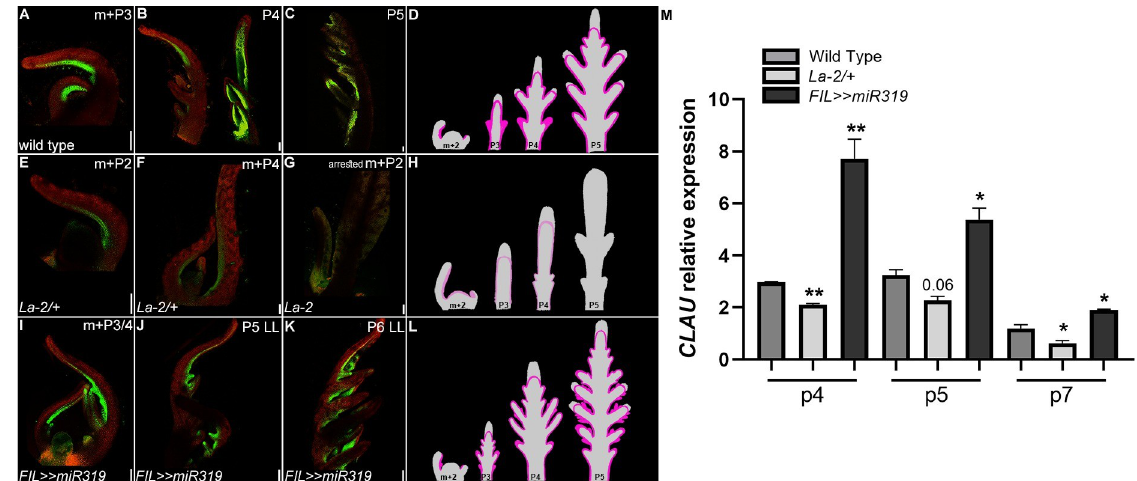
Fig 2. LA determines the developmental window in which CLAU is expressed. (A-L) Expression of the CLAUSA promoter CLAU :: nYFP in altered LA genotypes. (A-C) Expression of CLAU :: nYFP in different developmental stages of WT; (E-G) Expression of CLAU :: nYFP in different developmental stages of La-2/+ ( LA upregulation); (I-K) Expression of CLAU :: nYFP in different developmental stages of FIL >> miR319 (Reduced LA activity). The pattern of CLAU :: nYFP expression was detected by a confocal laser scanning microscope (CLSMmodel SP8; Leica), with the solid-state laser set at 514 nm excitation/ 530 nm emission. Chlorophyll expression was detected at 488nm excitation/ 700nm emission. Bars = 100 um. (D, H, L) : Cartoon summarizing the expression of CLAU :: nYFP throughout development in each genotype. (M) Expression levels of CLAU in altered LA genotypes was determined in successive leaf developmental stages using RT- qPCR. Graphs represent mean ± SE of three independent biological repeats. Asterisks indicate significant differences from CLAU expression in WT in an unpaired two-tailed t-test, p � 0.0387.